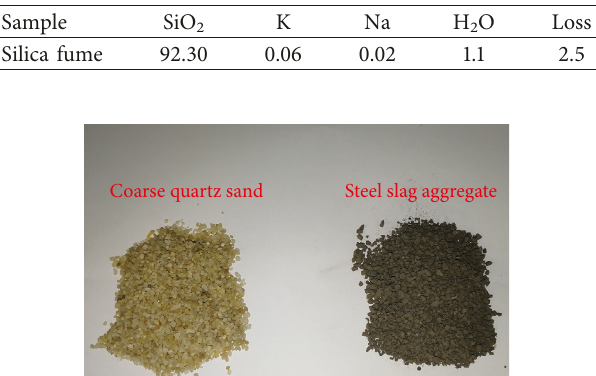
Table 2: Chemical compositions of the silica fumes (%).